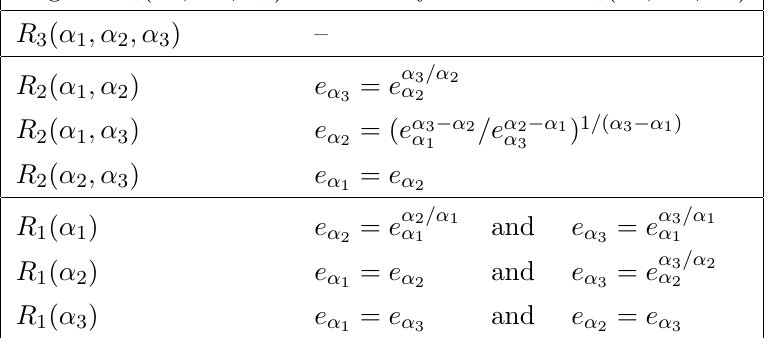
Table 1 . The boundary conditions of the various regions in the three-angularity phase space with (cid:11) 1 > (cid:11) 2 > (cid:11) 3